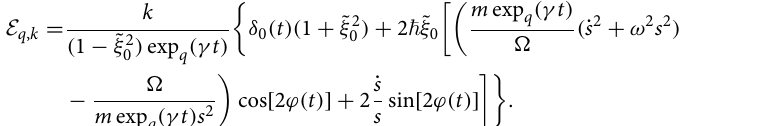
Figure 6. The dependence of the energy expectation value E q , k [Eq. (57)] on q . We used ω 1 , (cid:31) 1 , c 1 10 , k 1 / 4 , and s 0,1 m c 2 = = = = =